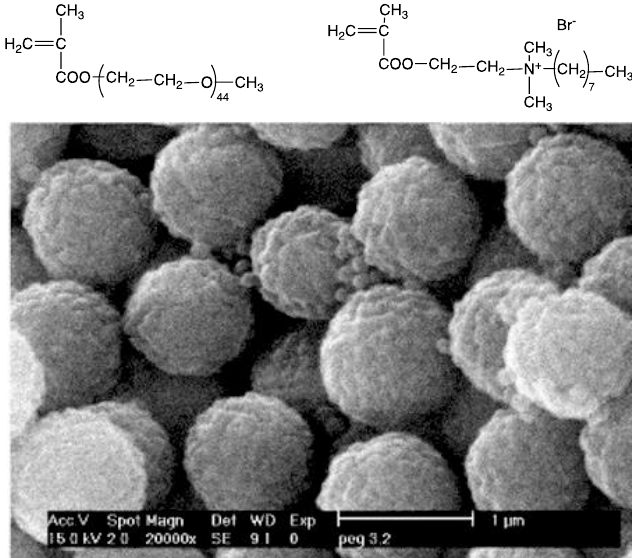
Figure 13. Scanning electron micrograph of PMMA core–PEG shell microparticles where the hydrophilic non-ionic co-monomer poly (ethylene glycol) methyl ether methacrylate and the cationic co-monomer 2-(dimethyloctyl) ammonium ethyl methacrylate bromine were used in the emulsion polymerization reaction. Reprinted from [242] with permission from Elsevier, Copyright 2011.